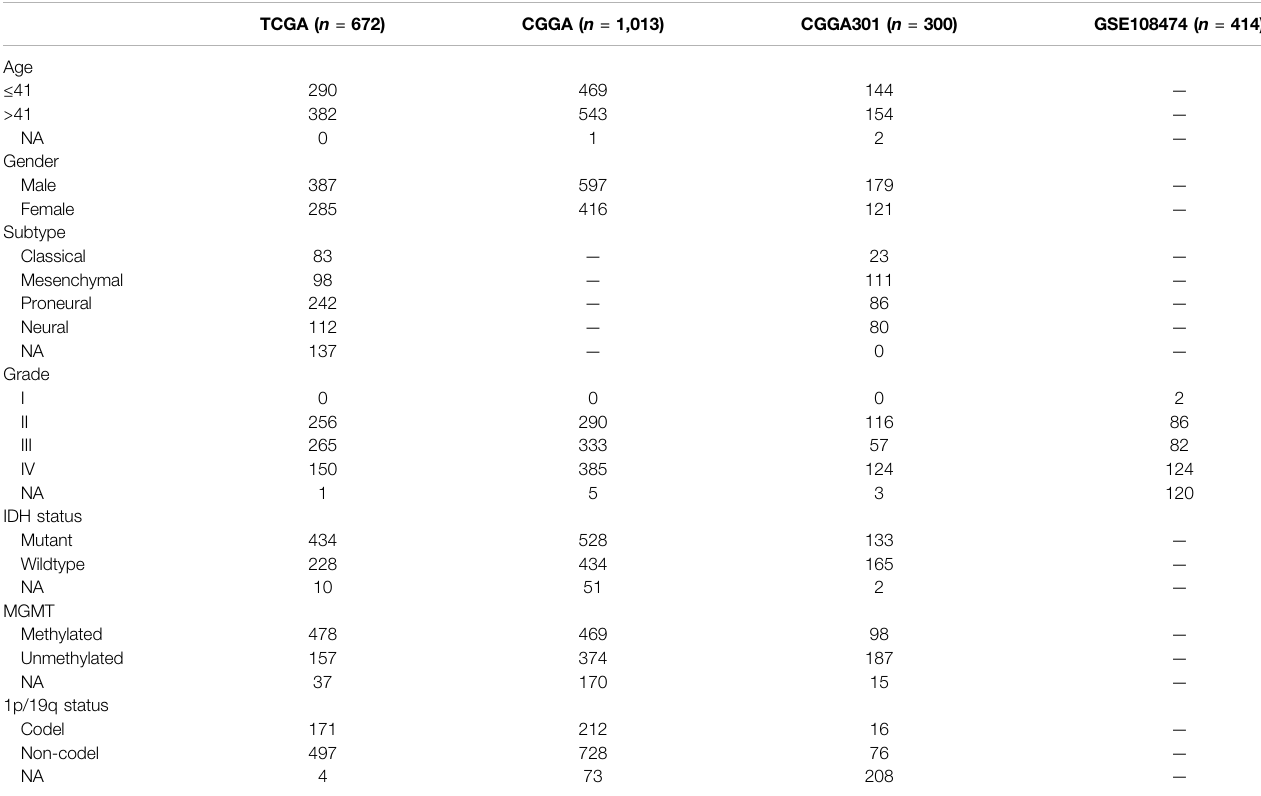
TABLE 1 | Characteristics of patients included in our